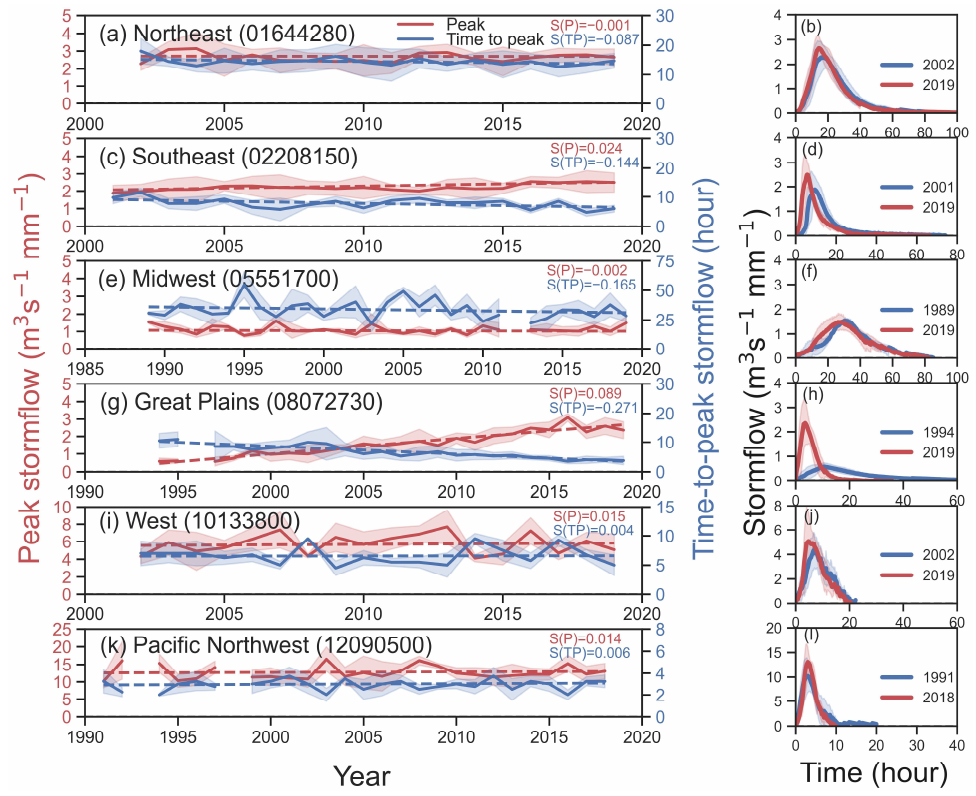
Figure 3. The first panel ( a , c , e , g , i , k ) shows the peak stormflow (red solid line) and time-to-peak stormflow (blue solid line) during the study years at six watersheds. The second panel ( b , d , f , h , j , l ) shows the average unit hydrographs for the start and end study years of the corresponding watersheds in the first panel (for example, the sub-figure ( b ) corresponds to the sub-figure ( a ) for the Northwest region watershed). The shaded area in both panel sub-figures is the standard deviation. The S(P) and S(TP) in the first panel are the slopes of trend lines of peak stormflow (red dashed line) and time-to-peak stormflow (blue dashed line), respectively. A few years of data are missing for three watersheds ( e , g , k ) due to limited streamflow data and/or due to limited stormflow events to generate unit hydrographs. Table 2. Trends in peak stormflow, time-to-peak stormflow, and urban (developed) area. Upward or downward trends are based on the positive or negative slopes of trend lines, respectively. The annual percent change of increase (positive values) or decrease (negative values) in peak stormflow (second column) and time-to-peak stormflow (third column) at each watershed is computed as a ratio of slopes of trend lines divided by their respective average values during the study years. The annual percent change in peak stormflow was multiplied by 10 to obtain the expected decadal percent change in peak stormflow (second column). The slopes of trend lines of time-to-peak stormflow were multiplied by 10 to compute expected changes in decadal time-to-peak stormflow (third column).